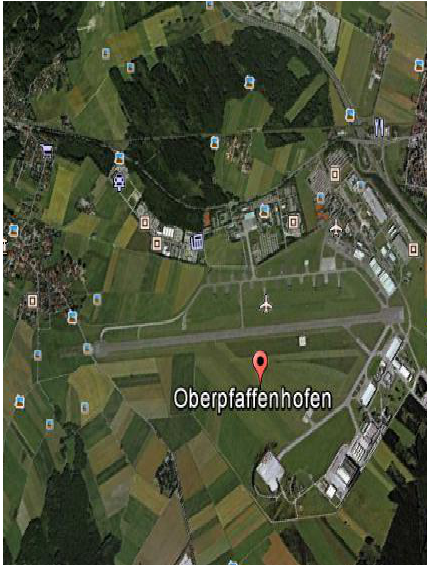
Figure 1. Optical image of Oberpfaffenhofen